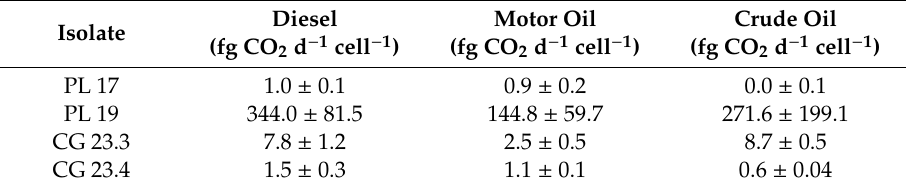
Figure 3. Cumulative carbon dioxide production during biodegradation of diesel, motor oil, and crude oil. Each data point represents the average and standard deviation of four replicates (blank corrected). Table 3. Degradation rates of hydrocarbon-containing substrates.